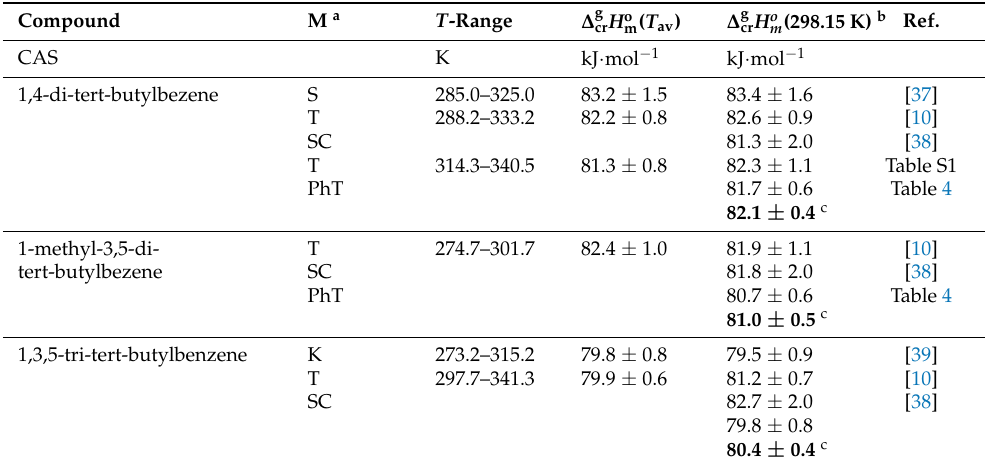
Table 3. Compilation of the enthalpies of sublimation, ∆ g cr H o m for the tert-butyl-benzenes derives determined in this work and from the data available in the